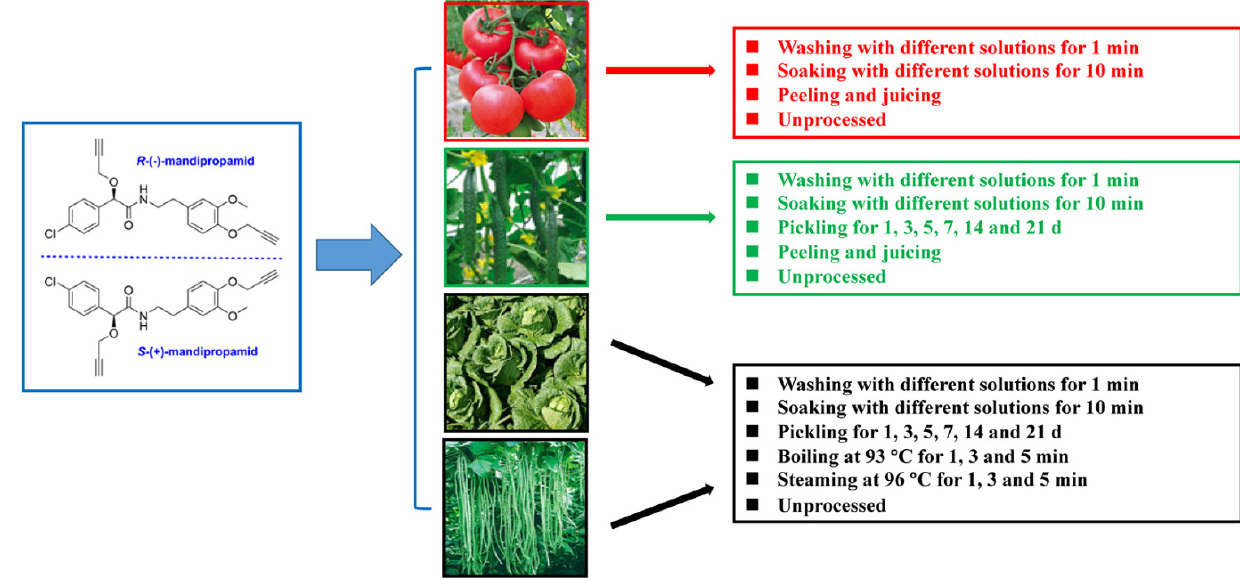
Figure 1. Scheme for assigning processing to four types of mandipropamid-treated vegetable sam- ples.